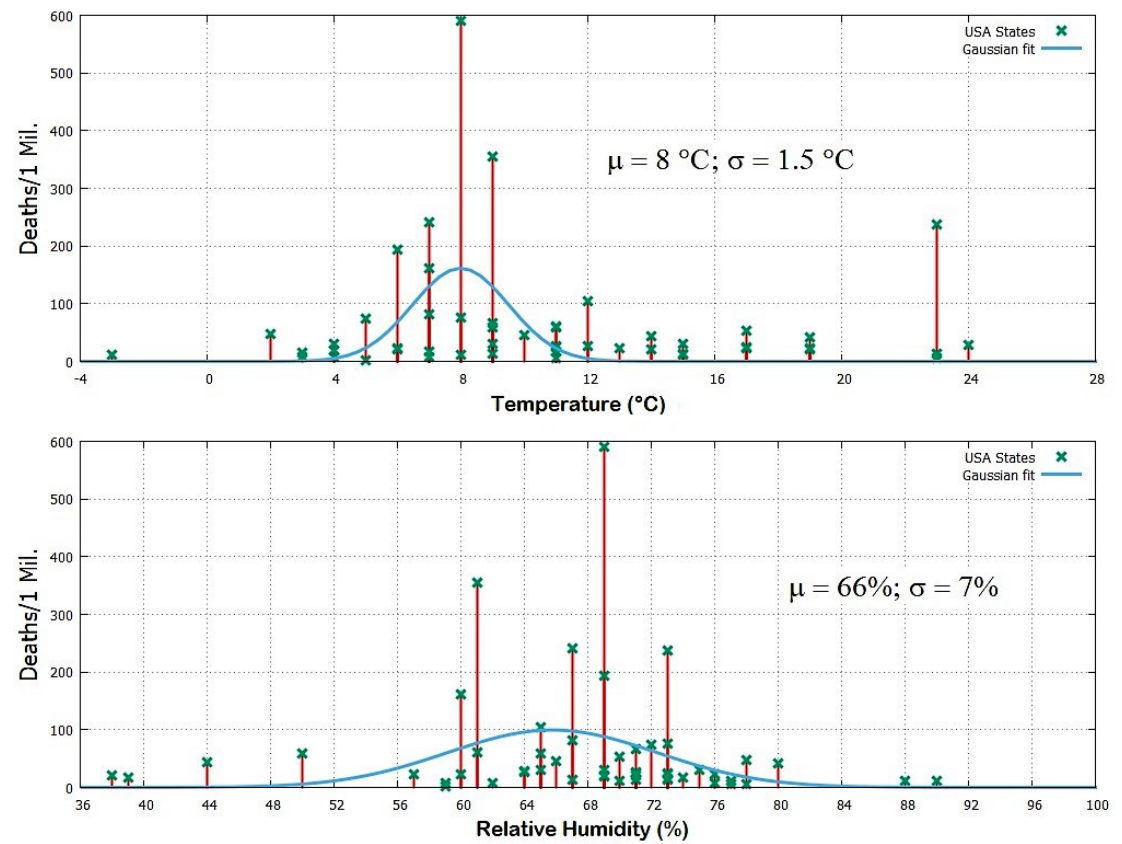
Figure 7. COVID-19 deaths per million people versus the mean temperature and mean relative humidity for March 2020 for the largest cities for each of the 51 states of the USA. See Table 4.